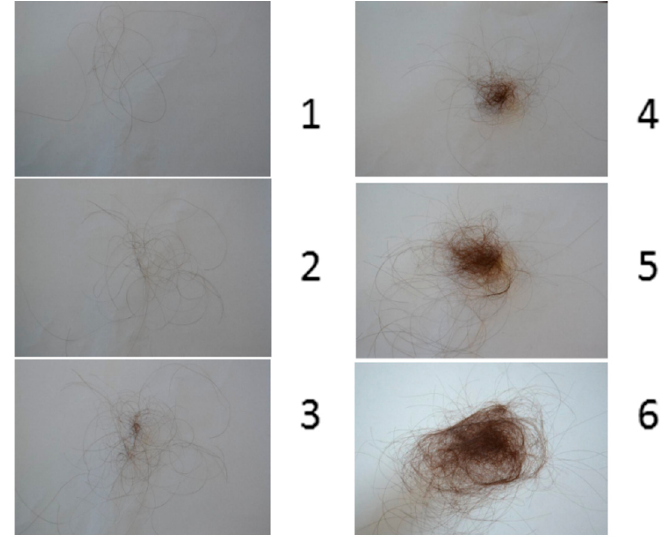
Figure 2. The women looked at an A4 page containing the six photos of hair bundles and were